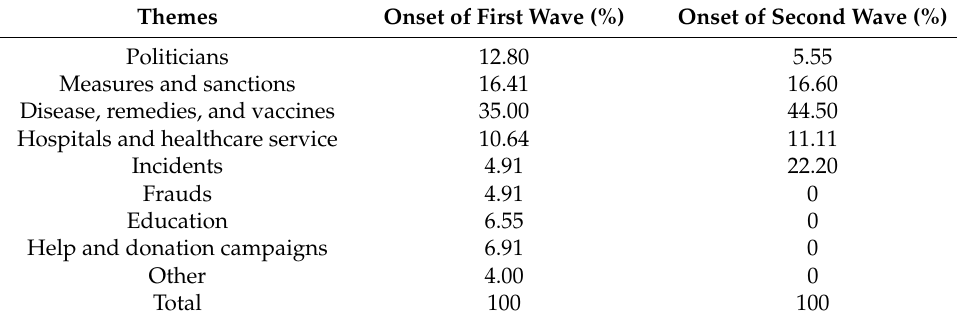
Table 1. Evolution of the hoax themes in the two stages of